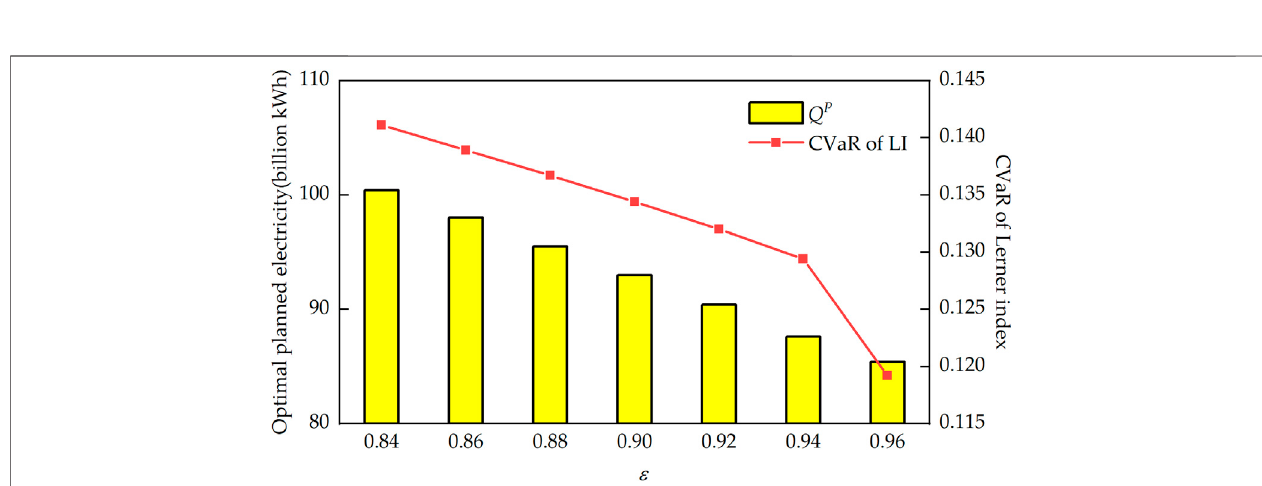
Frontiers in Energy Research |